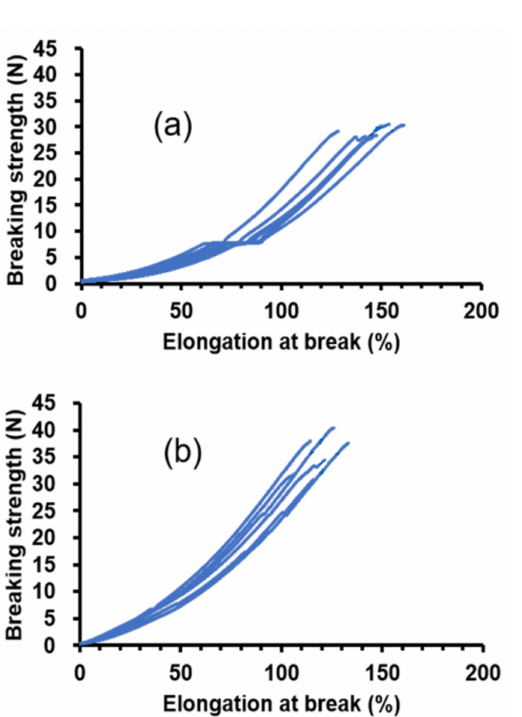
Figure 8. The stress-strain curves of the hydrated 3.5 mm-diameter SF knitted tubes ( a ) without and ( b ) with PU-SF composite sponge coating. The error bars are included in the figure. The averaged values of the breaking strength (N) and elongation at break (%) were ( a ) 29.1 ± 1.1 and 147 ± 11, and ( b ) 35.5 ± 3.8 and 120 ± 9,